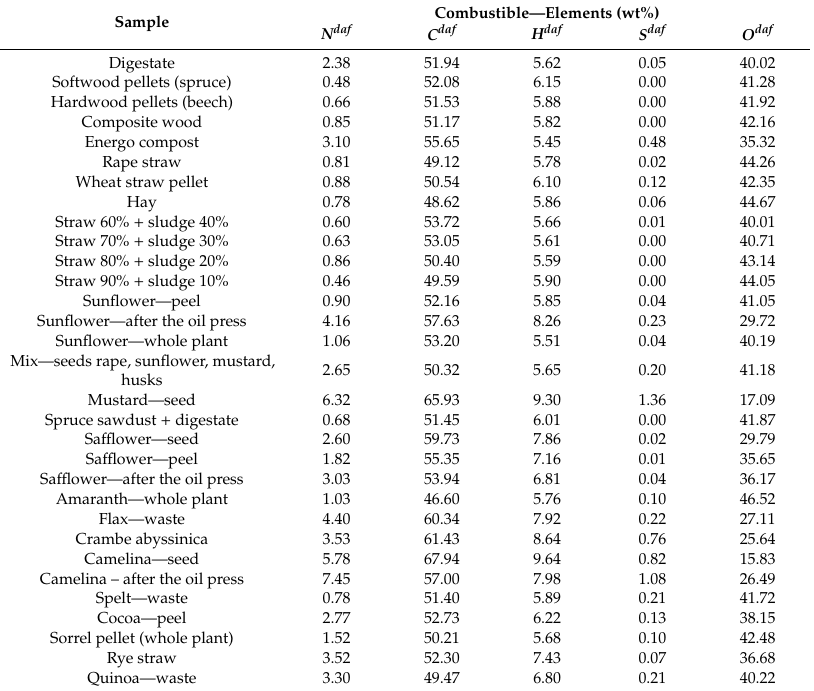
Table 7. Percentages of carbon, nitrogen, hydrogen, sulfur, and oxygen in the combustible